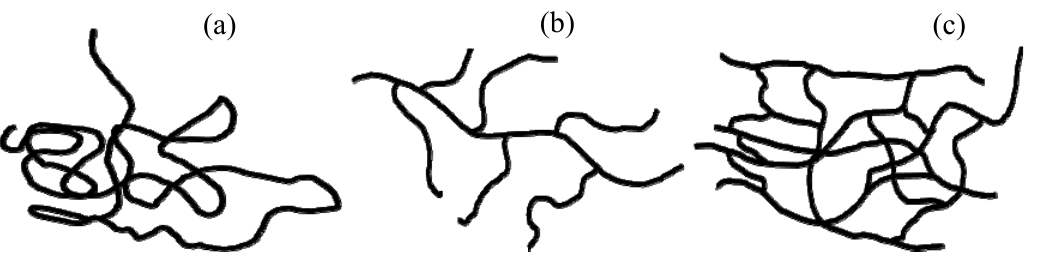
Figure 7. Macromolecular structure of polymers (a) Linear (b) Branched (c)